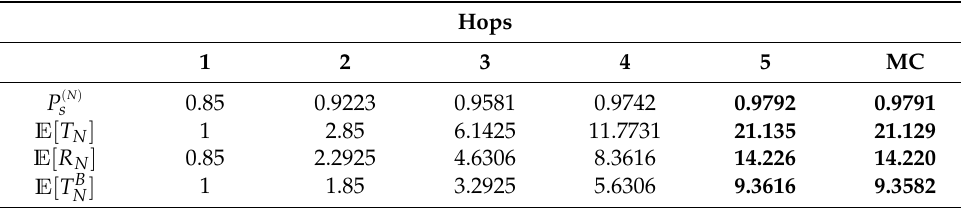
Table 1. Comparison of the true and estimated values for P ( N ) s , E [ T N ] , E [ R N ] and E [ T B